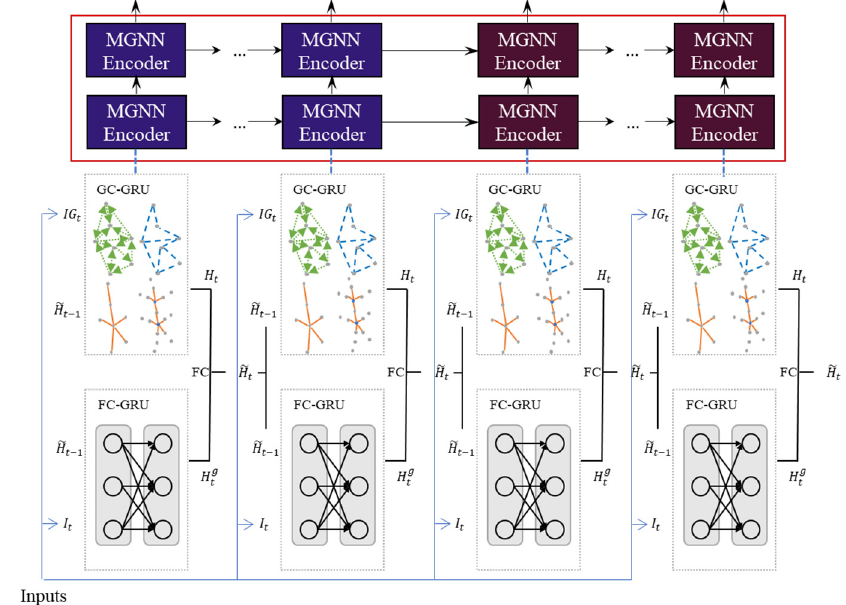
Figure 2. Illustrations for the Encoder–Decoder component of the GTFNN.